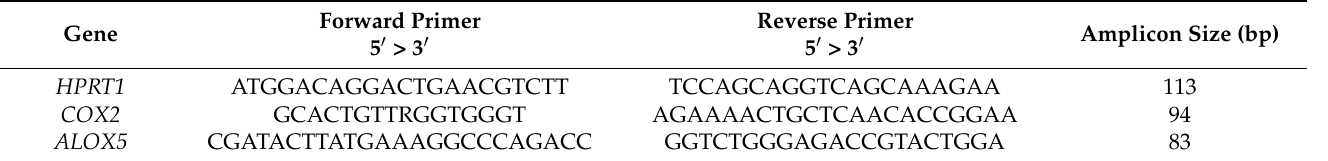
Table 1. Primers sequence used in mRNA